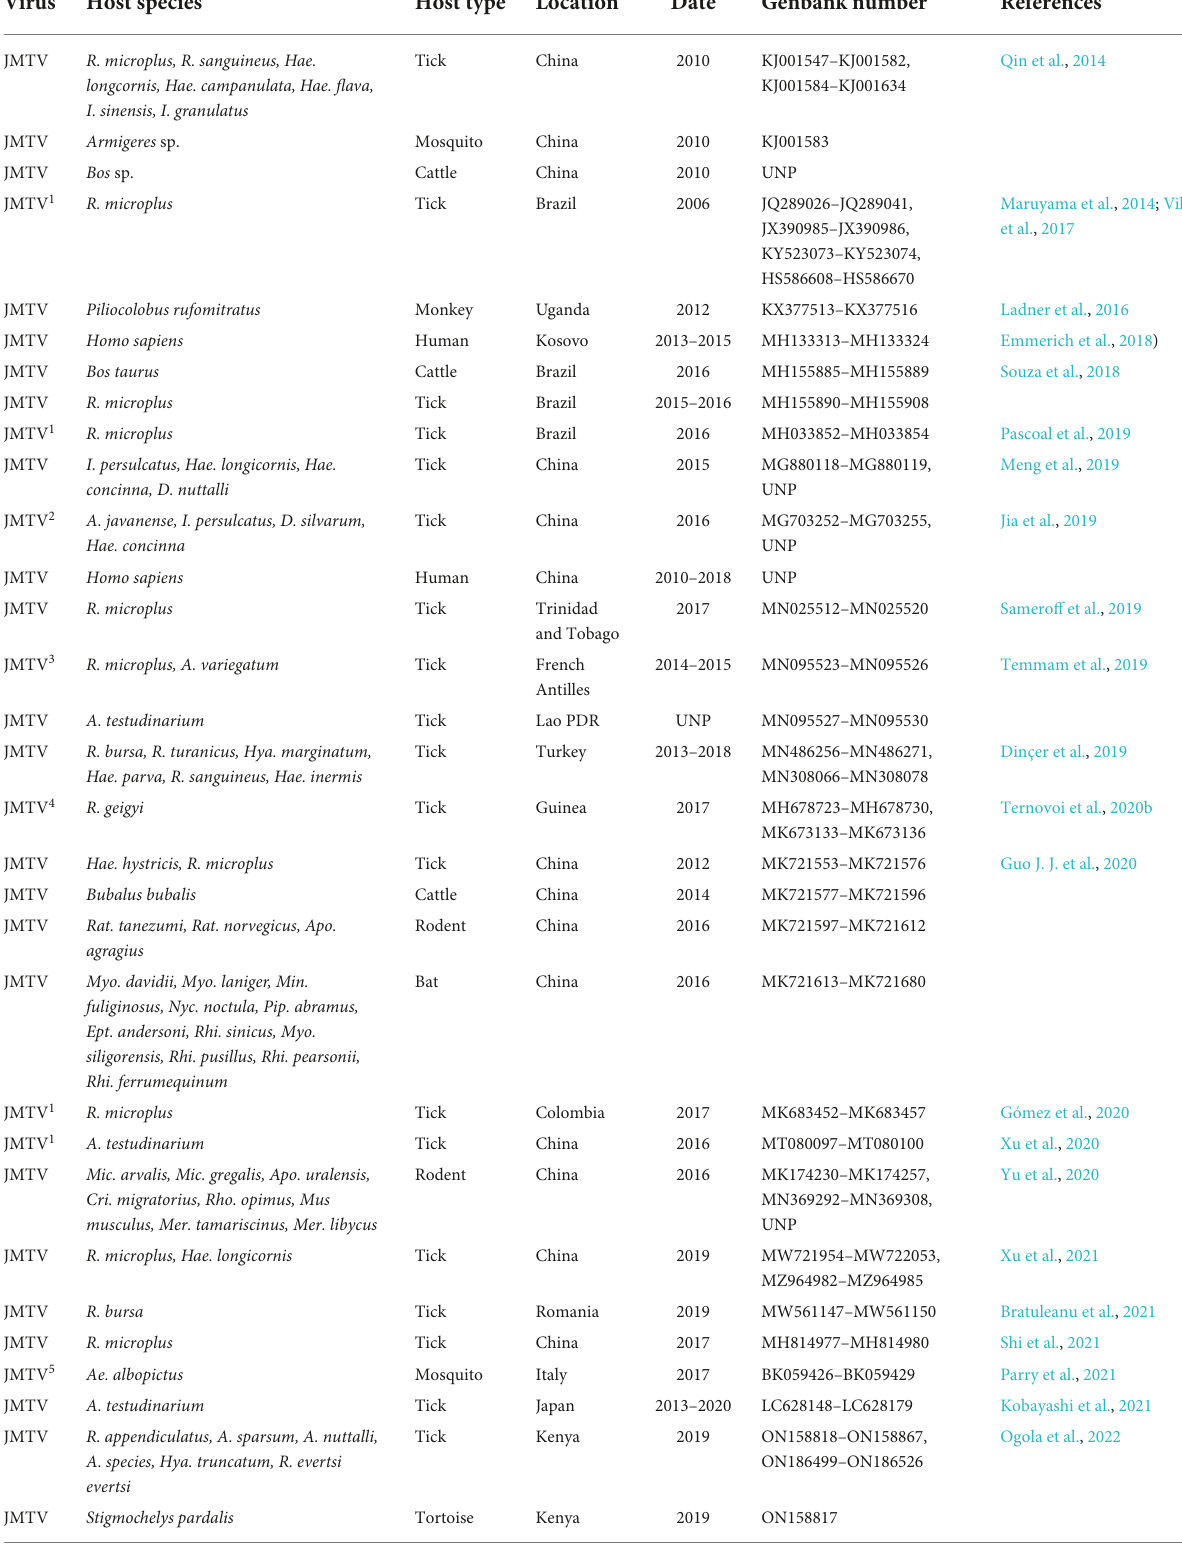
TABLE 1 Tick- and vertebrate-associated jingmenviruses RNA detections.